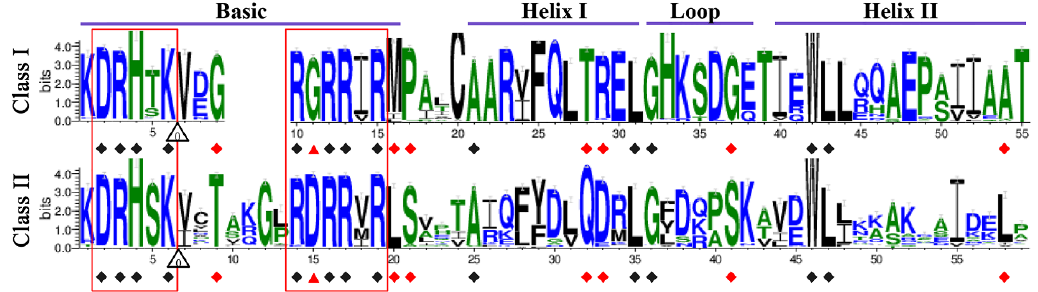
Figure 3. Sequence logos of the plant TCP protein domains. The sequence logos were obtained using the WebLogo online tool (http://weblogo.berkeley.edu/) [40], based on the alignments of the TCP domains. Bit scores indicate information content for each position in the sequence. The black rhomb represents conserved loci (90%) within the whole family. The red rhomb indicates divergent but conserved residues in each subgroup. The red triangle represents the key DNA binding site for the two subgroups. The red box represents the conserved consensus sequence found in all land plants. White triangles indicate the locations of introns, and the number within each triangle indicates the splicing phases of